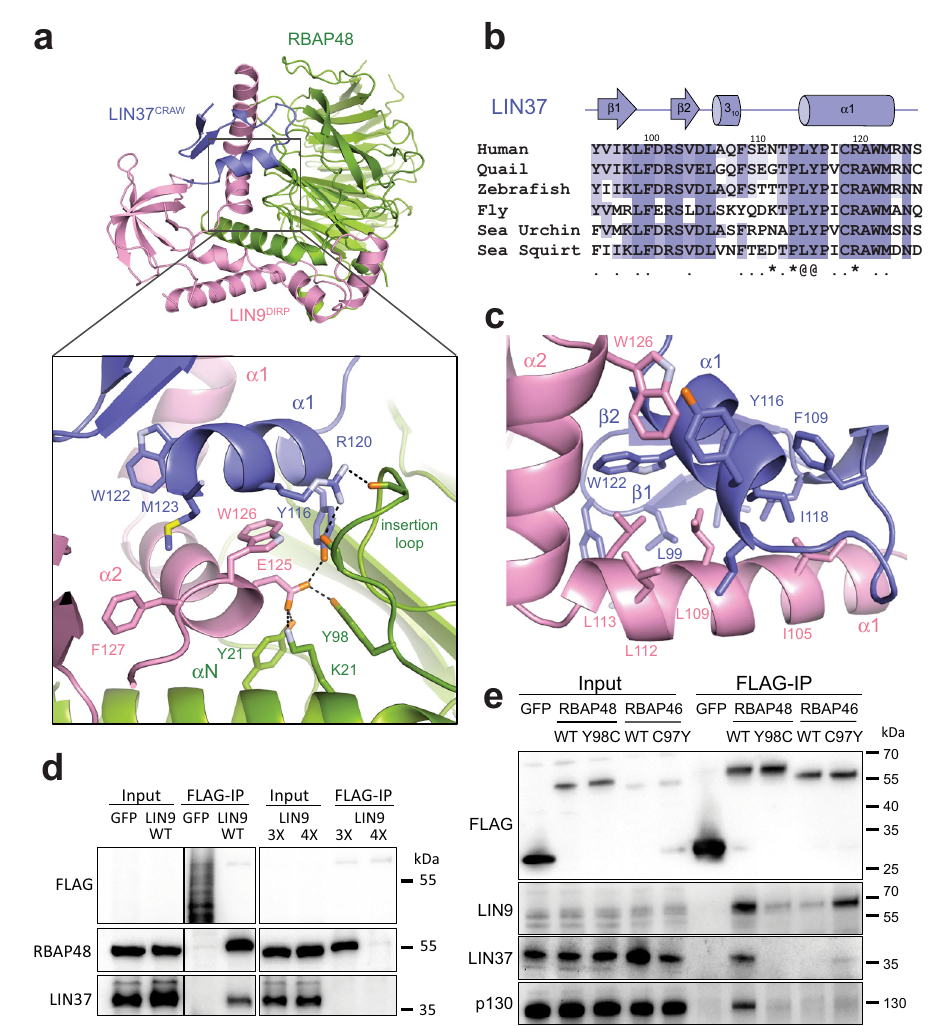
Fig. 3 LIN37 CRAW domain binds both LIN9 and RBAP48. a Interactions of LIN9 and LIN37 with the RBAP48 insertion loop. b Alignment of LIN37 sequences from organisms as in Fig. 2b. Residues that contact LIN9 (.), RBAP48 (*), and both LIN9 and RBAP48 (@) are indicated. c Close-up view of the LIN9-LIN37 interface. d The indicated FLAG-GFP control and FLAG-LIN9 WT and mutants were expressed by transient transfection in arrested HCT116 cells. Proteins were immunoprecipitated using anti-FLAG beads and the indicated proteins visualized by western blot. The 3x LIN9 mutant is E125A/W126A/F127A and the 4x LIN9 mutant is R174A/R175A/F180A/F181A. e Same as ( d ) but expressing the indicated RBAP46 and RBAP48 WT and mutant proteins. These immunoprecipitation experiments were performed each with a biological replicate, and results were